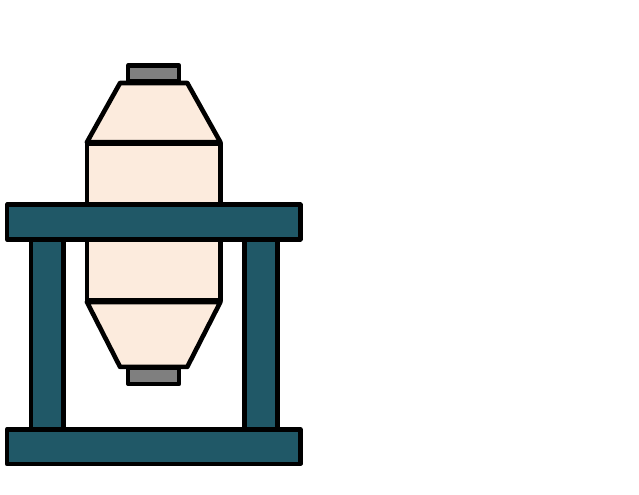
Figure 2. Schematic of a vertical vibration-insensitive optical cavity. (Figure reproduced from [33].)